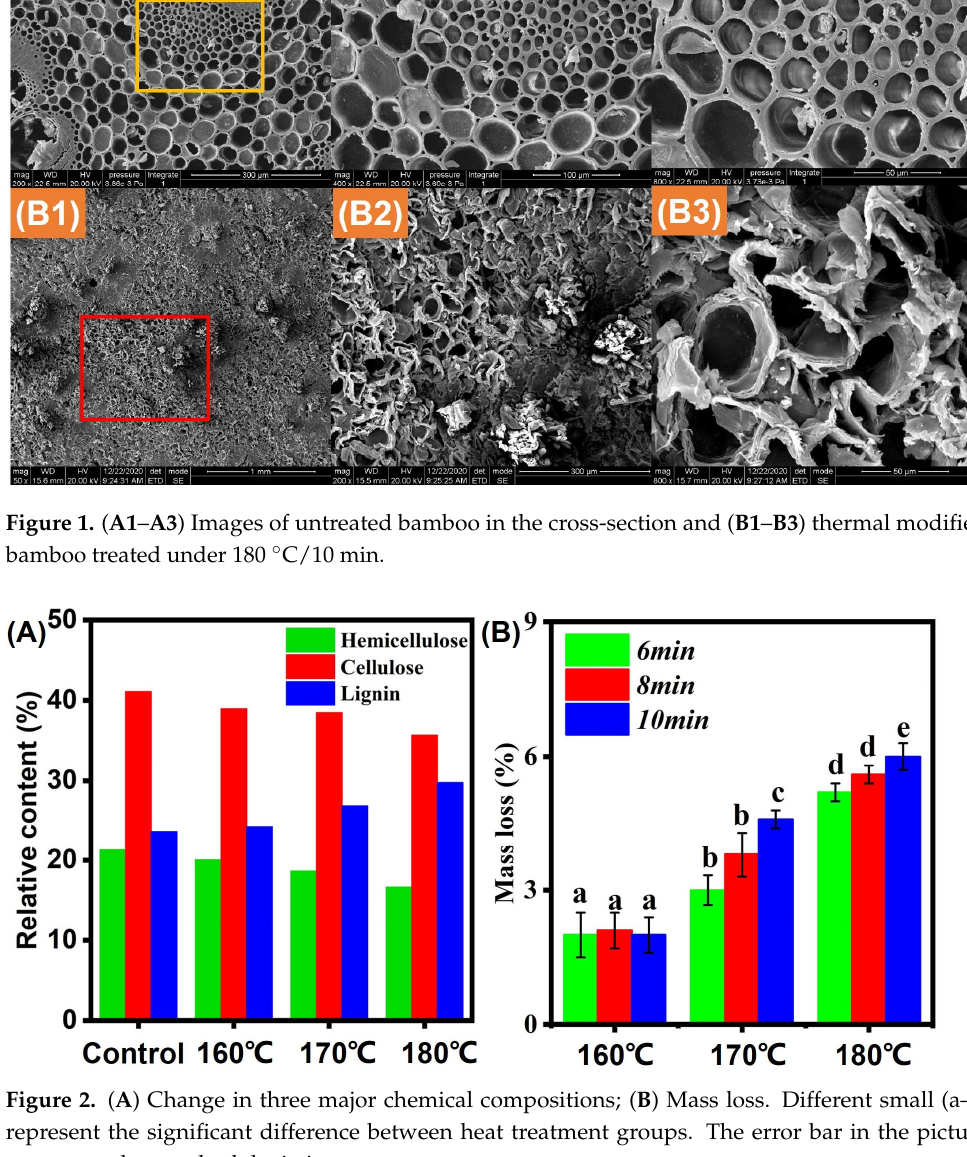
Figure 3. The starch content of different bamboo samples. 3.3. XRD and FTIR Analysis Figure 4A shows the XRD patterns and CrI of different bamboo samples. In the high temperature ‐ treated bamboo samples, the CrI increased from 40.5% to 59.5%. It is well known that biomass cellulose contains quasi crystalline regions, this being attributed to rearrangement or reorientation of cellulose molecules inside these regions. In addition, the degradation of cellulose in the amorphous region may happen at high temperatures, which results in more crystallization. Therefore, the crystallinity index of treated bamboo specimens increased. In addition, the decomposition of the para ‐ crystalline part of cellu ‐ lose can also make a positive contribution to the increment of cellulose crystallinity index [19–22].